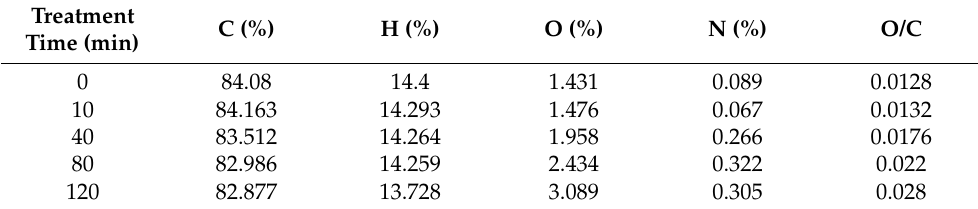
Table 3. Element analysis of LDPE at different treatment times.